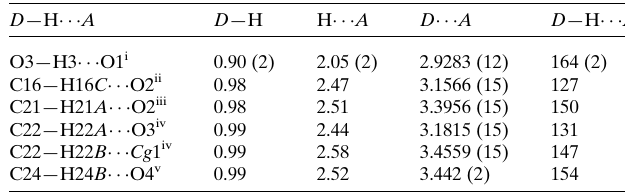
Table 1 Hydrogen-bond geometry (A˚ , (cid:3) ).